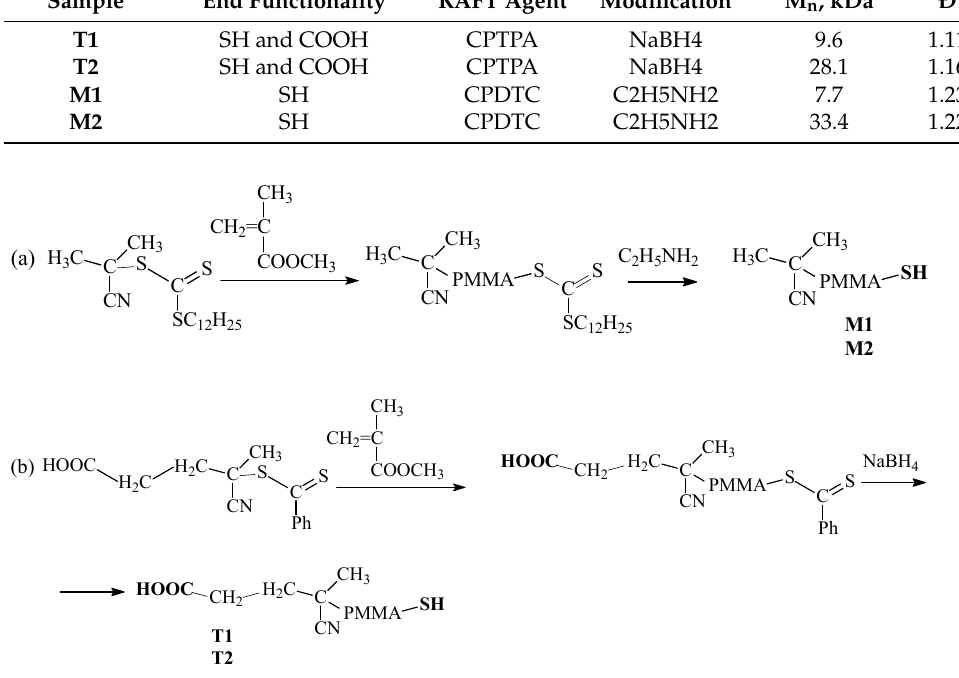
Figure 13. Synthetic route and designation of monochelic PMMA ( a ) and telechelics of PMMA ( b ).